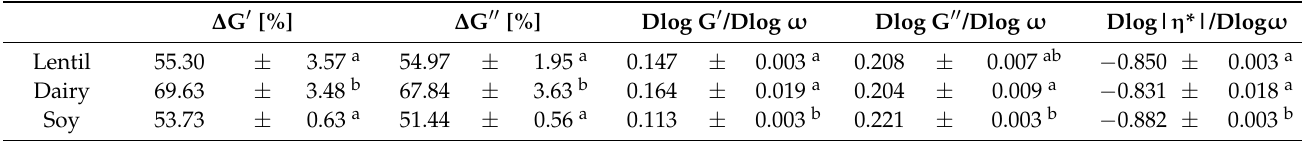
Table 2. Results of the thixotropy test ( ∆ G (cid:48) [%] and ∆ G” [%]) and the frequency sweep (dlog G (cid:48) /dlog ω , dlog G (cid:48)(cid:48) /dlog ω , dlog| η *|/dlog ω ). Values within columns with different superscript letters are significantly different ( p ≤ 0.05). ∆ G (cid:48)